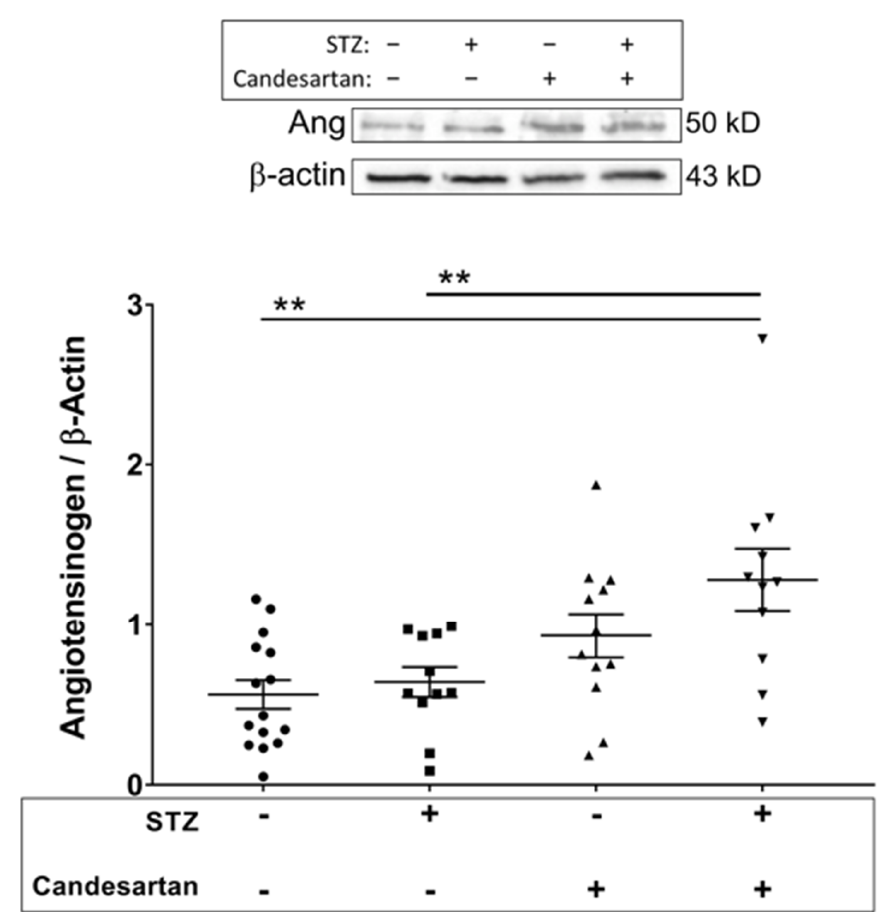
Figure 2. Retinal tissue protein levels (Western blot data; normalized to β-actin) of angiotensin converting enzyme (ACE) in the four groups of rats: untreated non-diabetic controls, untreated STZ, candesartan-treated non-diabetic controls, and candesartan-treated STZ. ACE levels were increased in the diabetic rats, but only in the absence of candesartan treatment. N = 10–13 per group, * p < 0.05 between indicated groups.